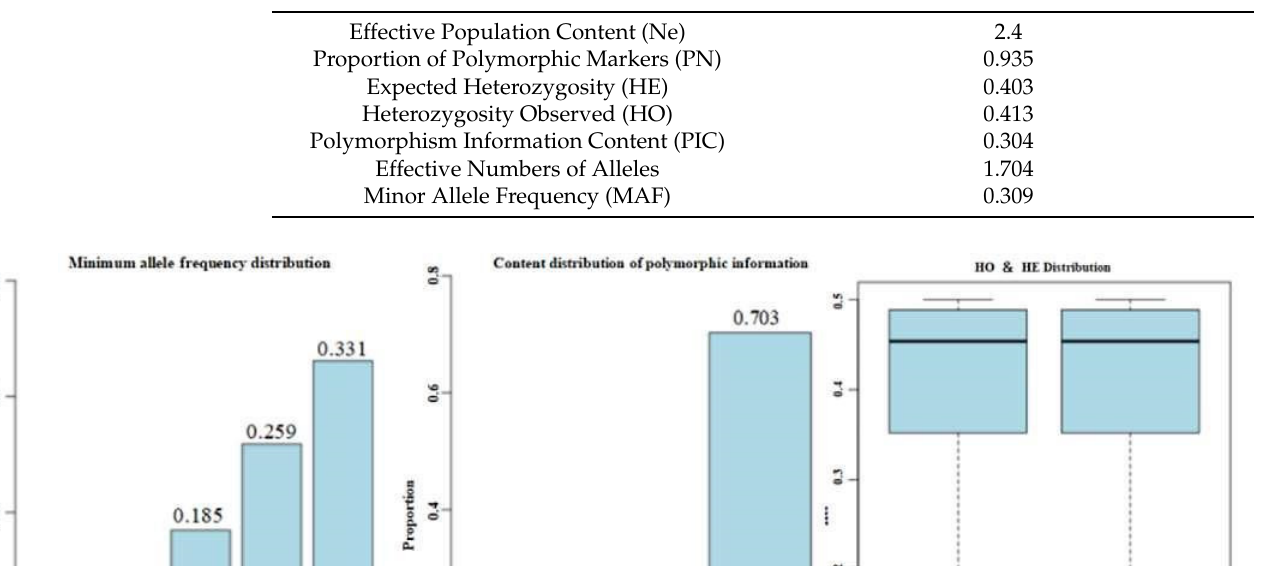
Table 2. Analysis results of population genetic diversity.